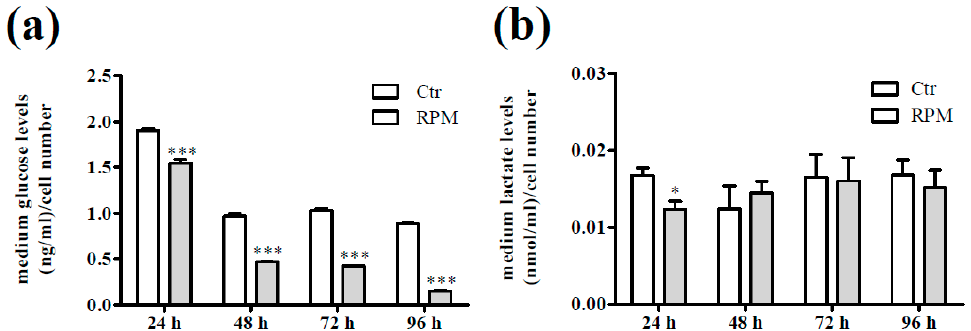
Figure 5. Cellular metabolism after exposure to s-microgravity. ( a ) Glucose levels were measured in the growth medium of cells grown at 1 g (Ctr) or exposed to s-microgravity (RPM) and are expressed as the ratio between glucose levels (ng / mL) and the number of cells at each time point. ( b ) Lactate levels were measured in cell medium from cells grown under the same conditions as described in ( a ) and are expressed as the ratio between lactate levels (nmol / mL) and the number of cells at each time point. Values are presented as means ± SEM, n = 3. * p < 0.05, *** p < 0.001 compared with the corresponding Ctr.